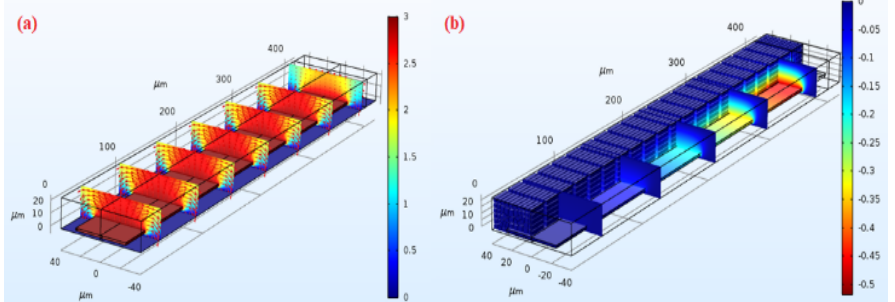
Figure 16. The electrostatic simulation results of a microcantilever with L = 400 µ m and applying a force of 16.4 nN, which is as a result of airflow velocity V = 5m / s. ( a ): Electrical filed vectors; ( b ) Electrostatic potential with microcantilever deflection